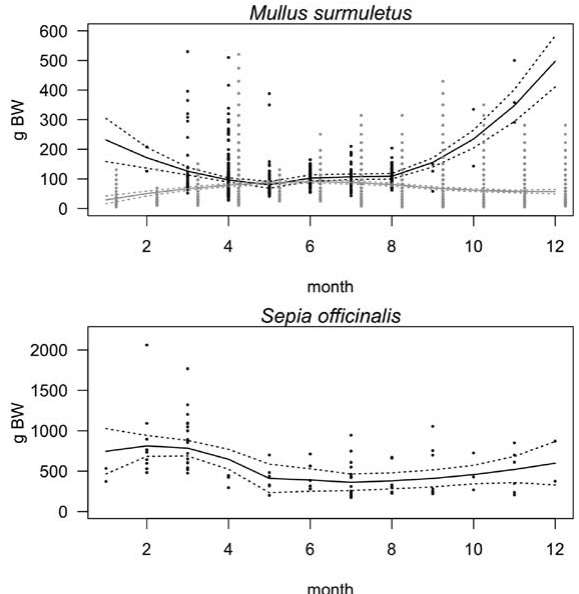
Fig. 3. – Top: Body weight of individual striped red mullet ( Mullus surmuletus ) measured on board along a 12-month sampling period (grey circles, bottom trawl; black circles, trammel net). Smooth loess predictor of monthly mean body weight with 95% confidence interval (grey lines, bottom trawl; black lines, trammel net). Bot- tom: Body weight of individual cuttlefish ( Sepia officinalis ) with smooth loess predictor and confidence intervals for both fishing gears